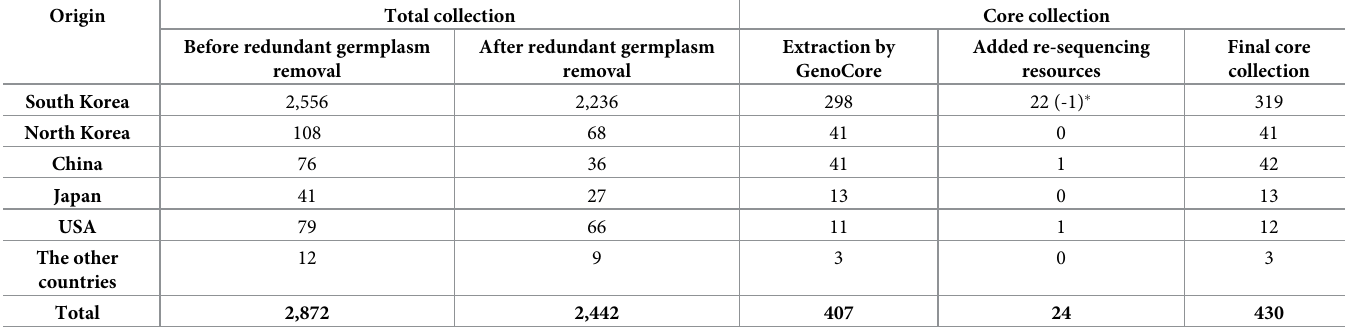
Table 2. Construction of the core collection by using Axiom 1 180K SoyaSNP array and GenoCore. Origin